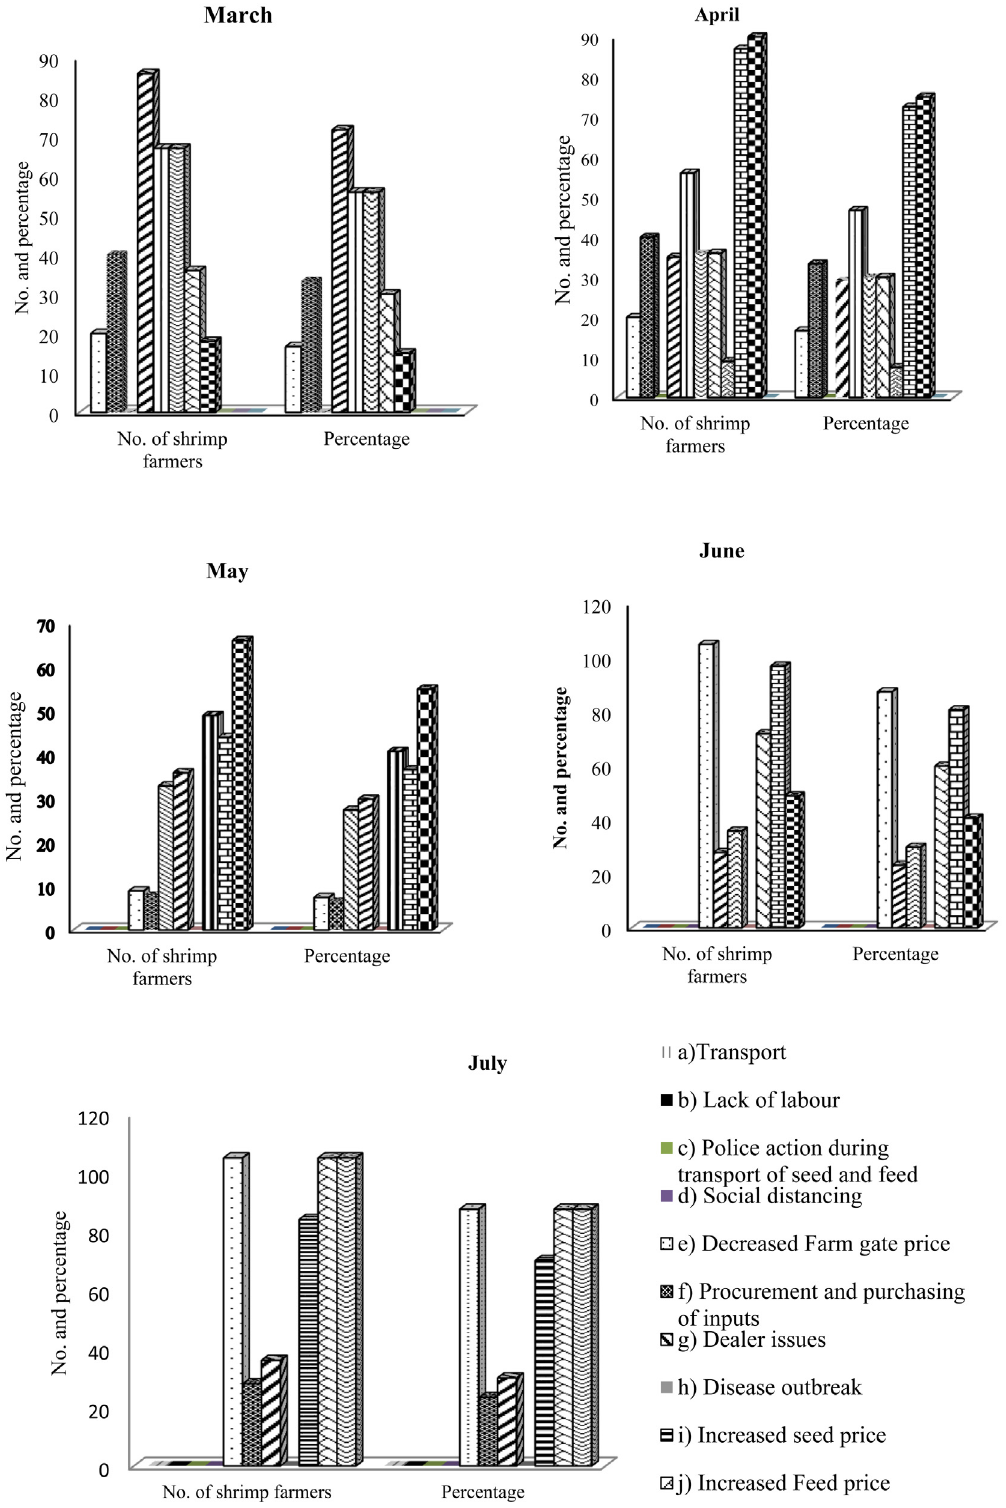
Fig. 4. Constraints faced by the farmers during COVID-19 in Site-BW in different months (Legends are identical in each